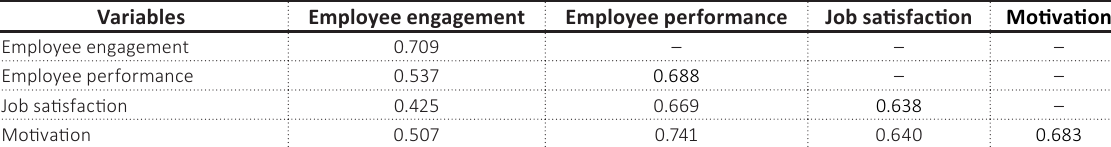
Table 3. Discriminant validity (Fornell-Lacker criterium)